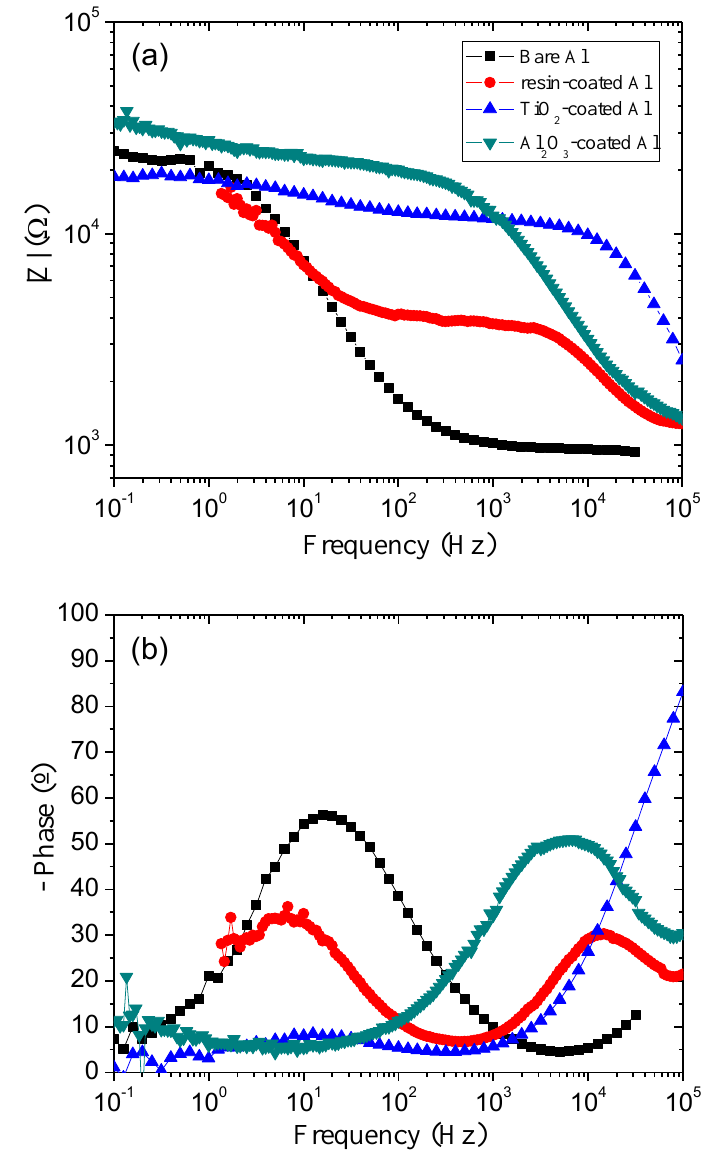
Figure 5. Bode magnitude ( a ) and Bode phase ( b ) plots of the electrochemical impedance spectroscopy for the studied samples.